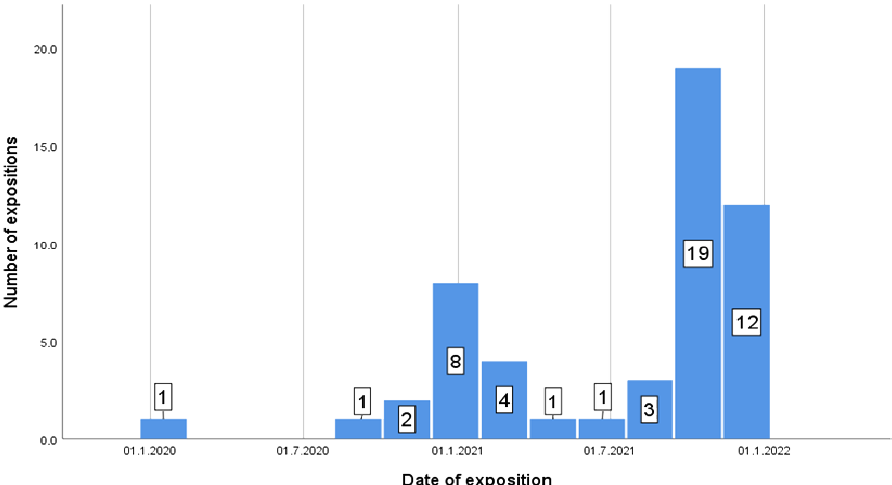
Figure 5. Frequency of exposure to an infected person by the date.